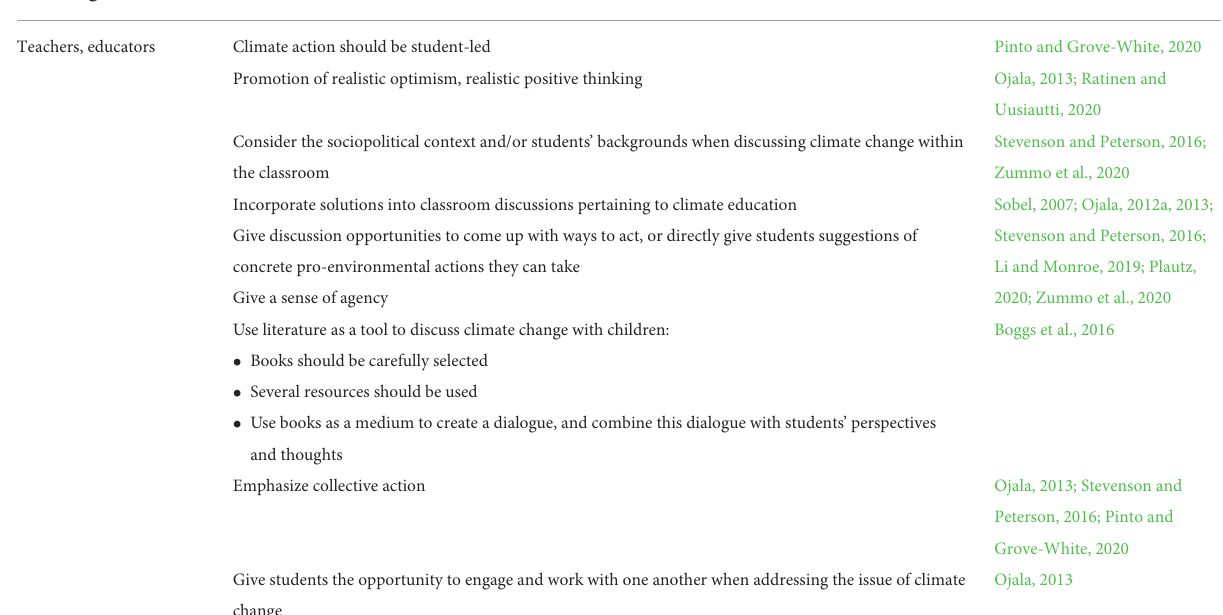
TABLE 5 Considerations per